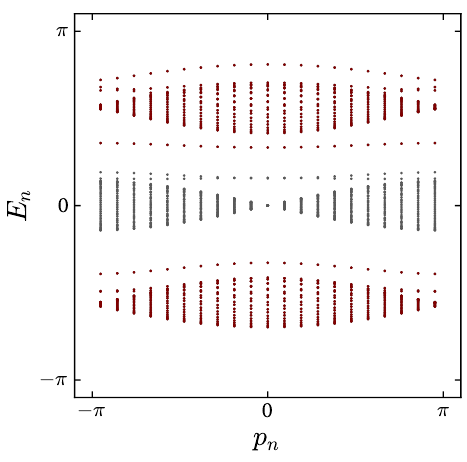
) plane, for φ = π/ 3 (other parameters as in Fig. 2). Figure 3: Band structure in the ( p , E n n Note the appearance of bound modes within the gaps in the presence of interaction. These modes correspond to the the two particles occupying the same location. (The bands are colored for